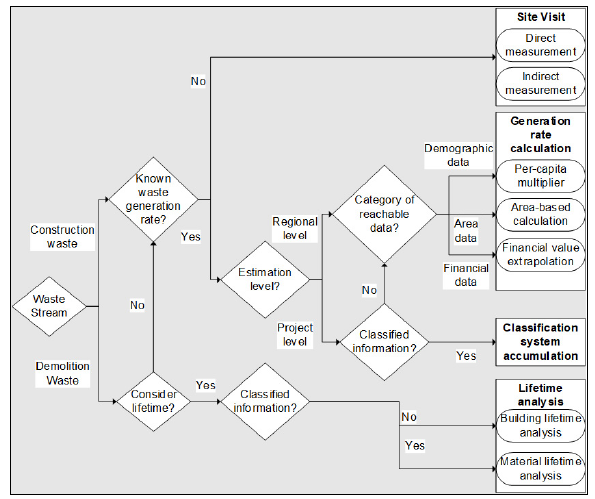
Figure 1: Relevance tree for methodology selection (from Wu et al. 5